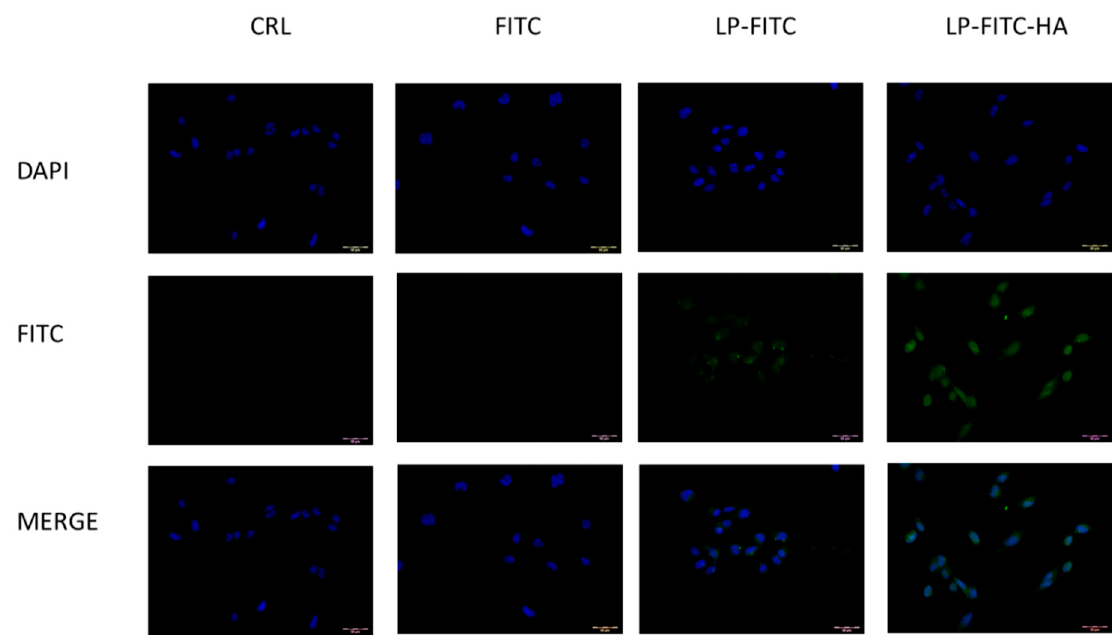
Figure 5 . Cellular uptake of FITC, LP ‐ FITC, and LP ‐ FITC ‐ HA by HConEC cells after 1 h incubation at 37 °C. Images of nuclei stained with DAPI (blue) and FITC (green) and their overlay. Scale bar: 20 μ m.